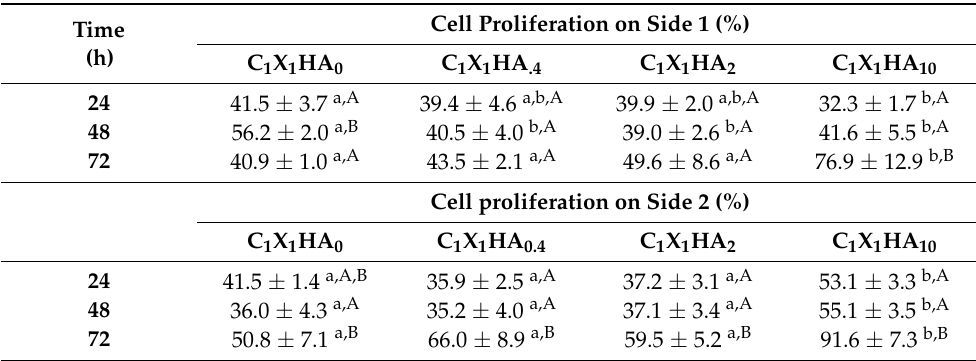
Table 3. Percentage values of cell proliferation over the smoother and rougher surfaces (sides 1 and 2, respectively) of the membranes in comparison to the control (polystyrene culture